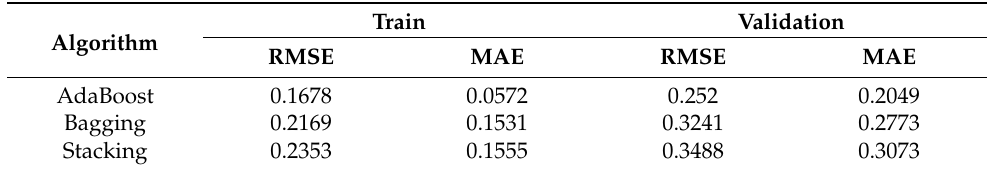
Table 5. Result of metrics indices.